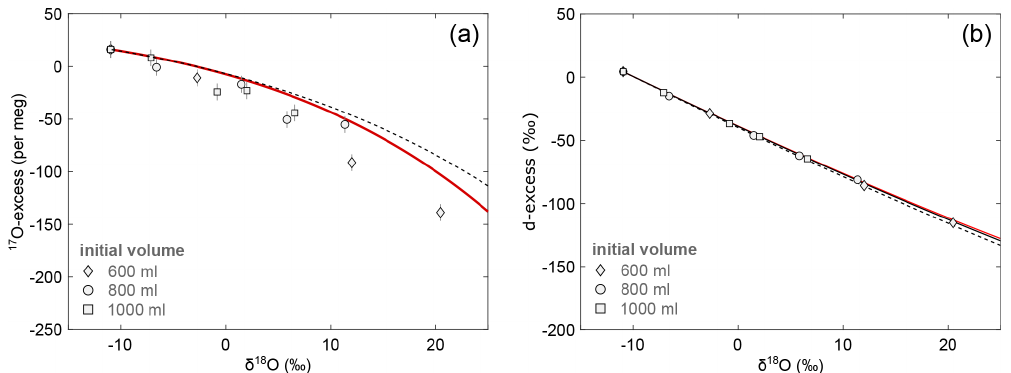
Figure 6. Isotopic data of pan evaporation experiments in the diagrams of (a) 17 O-excess over δ 18 O and (b) d-excess over δ 18 O. Pan evaporation experiments were carried out with different initial volume of 600mL (diamonds), 800mL (circles), and 1000mL (squares). Note that the symbol size can be larger than the error bars. The solid black line in panel (b) shows the best fitting evaporation trajectory ( n = 0 . 55) for the simple evaporation model. The red lines represent the evaporation trajectories modelled using the virtual outlet model with n = 0 . 59 and an outlet of 20% (see text). Dashed lines illustrate the evaporation trajectories modelled with the simple evaporation model using the same turbulence coefficient as for the virtual outlet model. Model input parameters are summarized in Table 2.